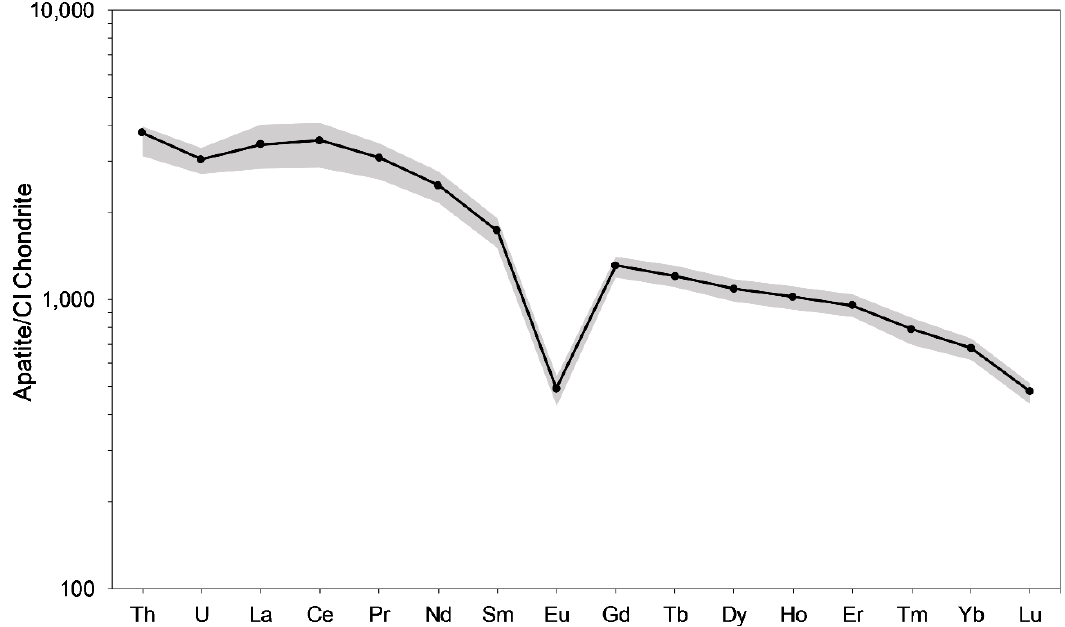
Figure 11. Apatite U-Th-REE concentrations as derived from LA-ICP-MS normalized to CI chondrite of McDonough and Sun [29]. The black line represents the average trace element concentration in apatite from the Silver Crater Mine normalized to CI chondrite (n = 9), whereas the gray area represents the range of the dataset (Table S1).